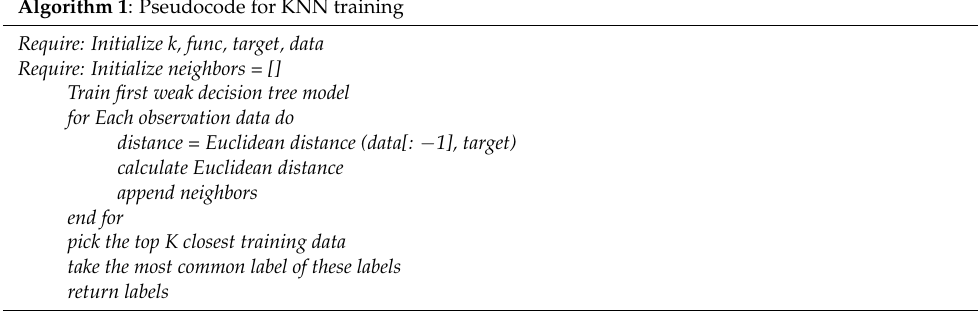
Algorithm 1 : Pseudocode for KNN